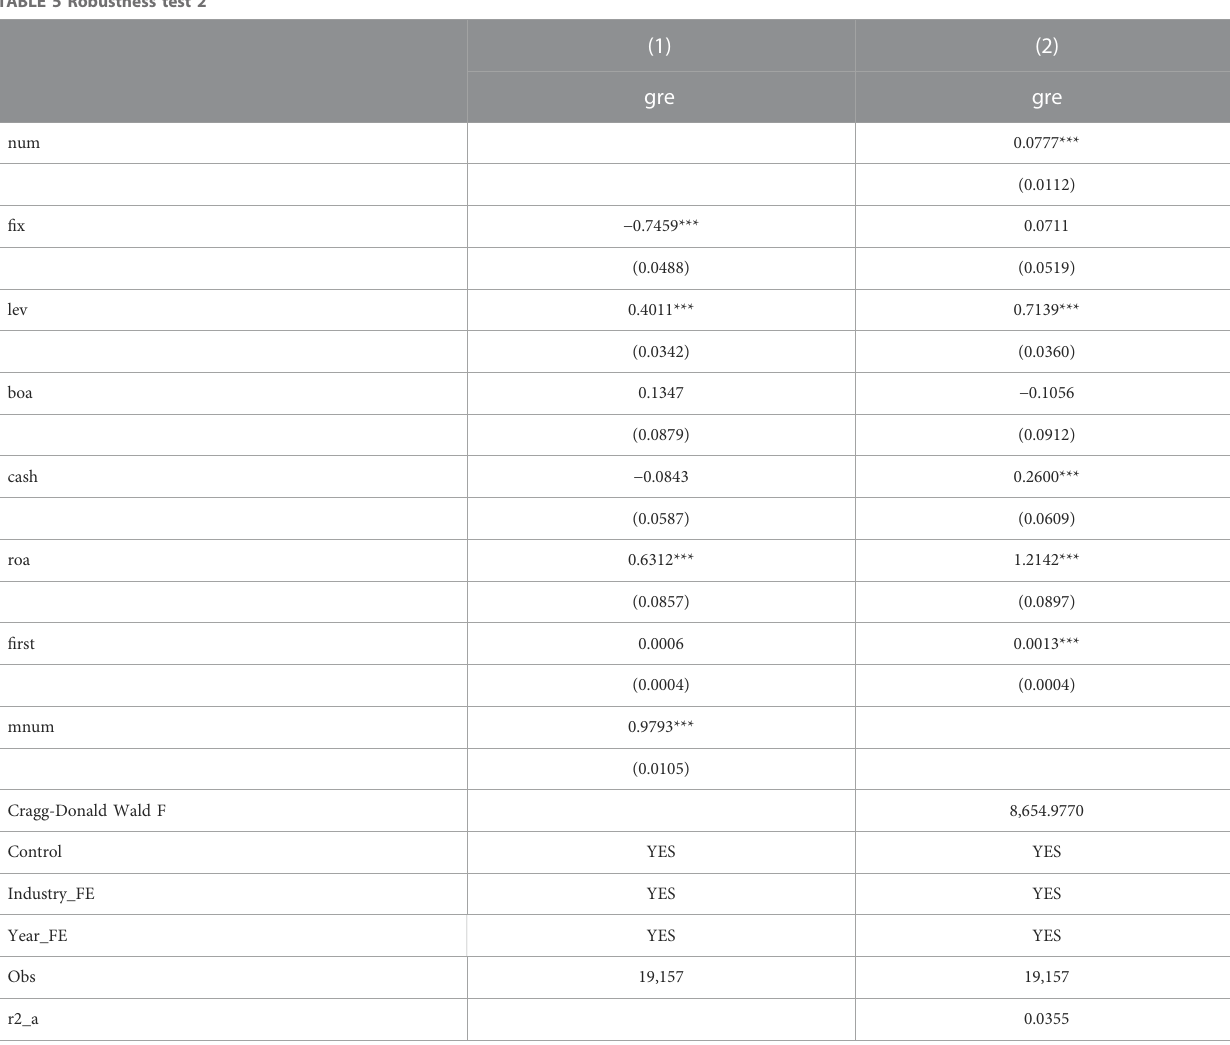
TABLE 5 Robustness test